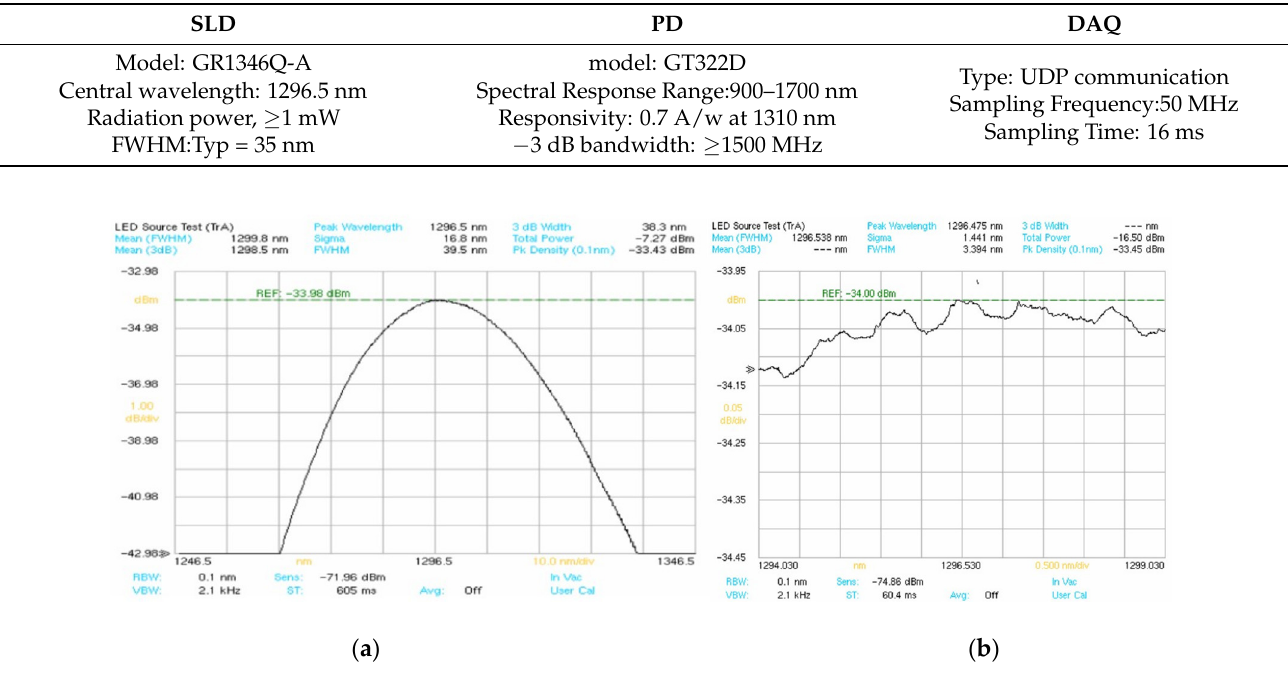
Figure 7 . The tested spectrum of the source: ( a ) spectrum curve, ( b ) wavy curve around the central wavelength.